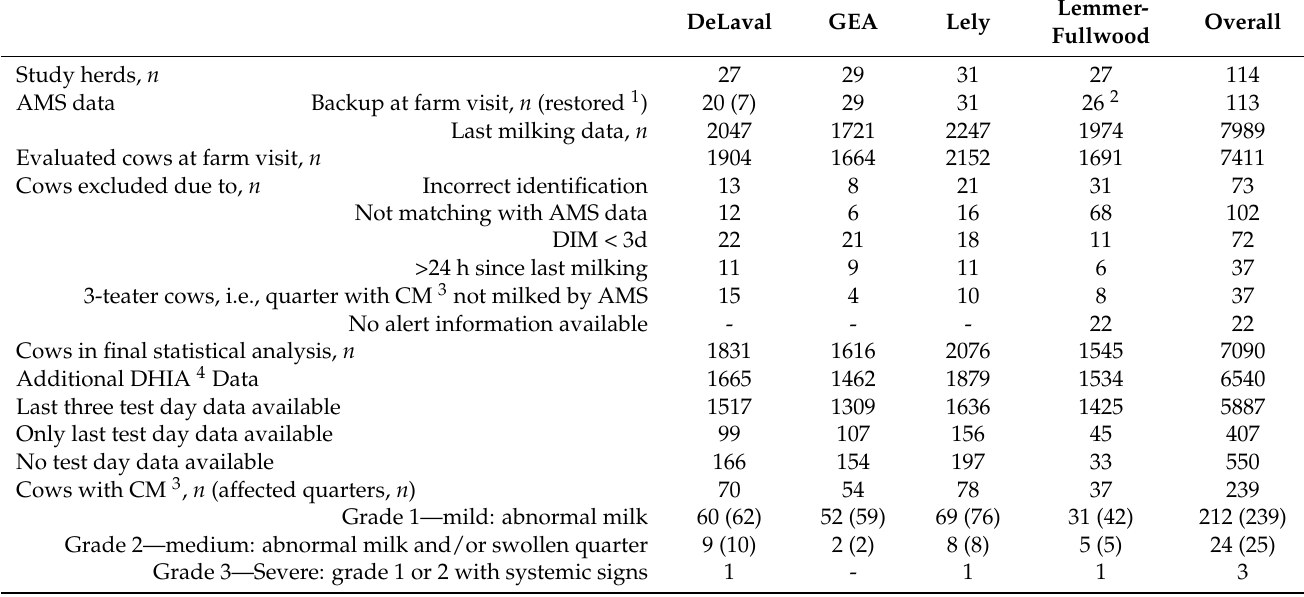
Table 3. Overview of data-cleaning process in a study on AMS system accuracy in Bavarian dairy herds. DeLaval